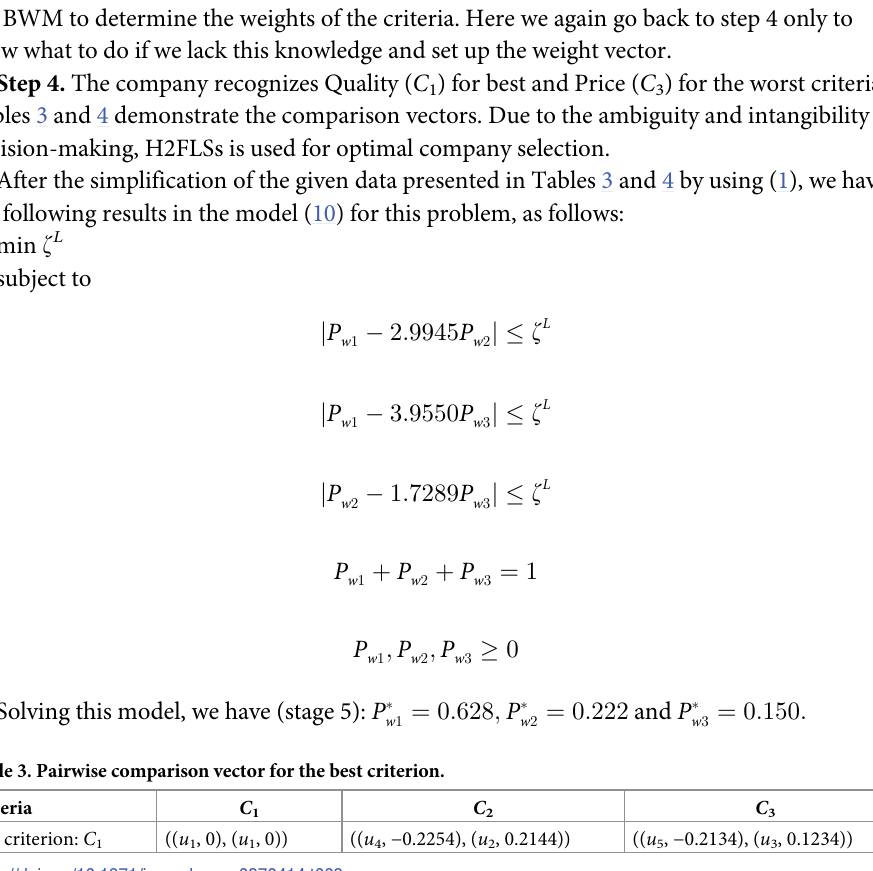
Step 6. In response to the estimations of correlation coefficients in step 3, the alternatives